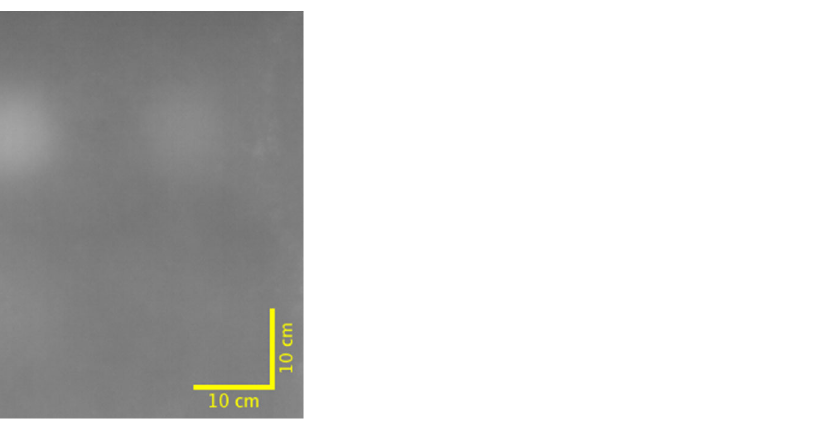
Figure 7. Horizontal and vertical scale bars of 10 cm in length, applied to the specimen’s thermogram.